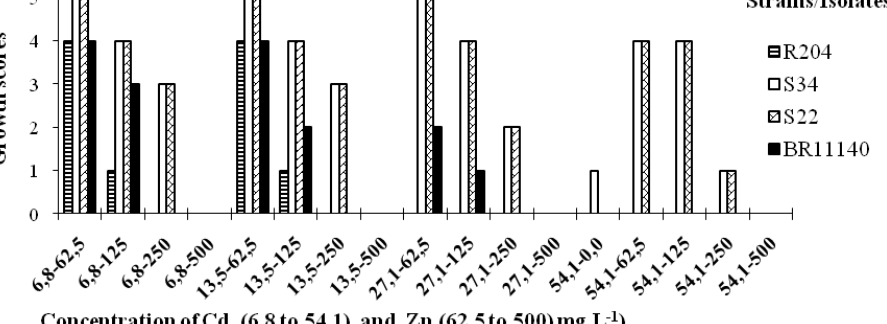
Fig. 3 – Growth scores of Azospirillum amazonense type strain (BR11140 T ) and isolates (R204, S34, S22) from heavy metal contaminated area in potato dextrose agar medium supplemented with different concentrations of Cd 2+ + Zn 2+ (mg L -1 ) ten days after inoculation. 0 = no visual growth, 1 = very reduced growth, 2 = low growth, 3 = intermediate growth, 4 = abundant growth, 5 = very abundant growth as compared to the growth of the strain/isolate in the same medium without heavy metal